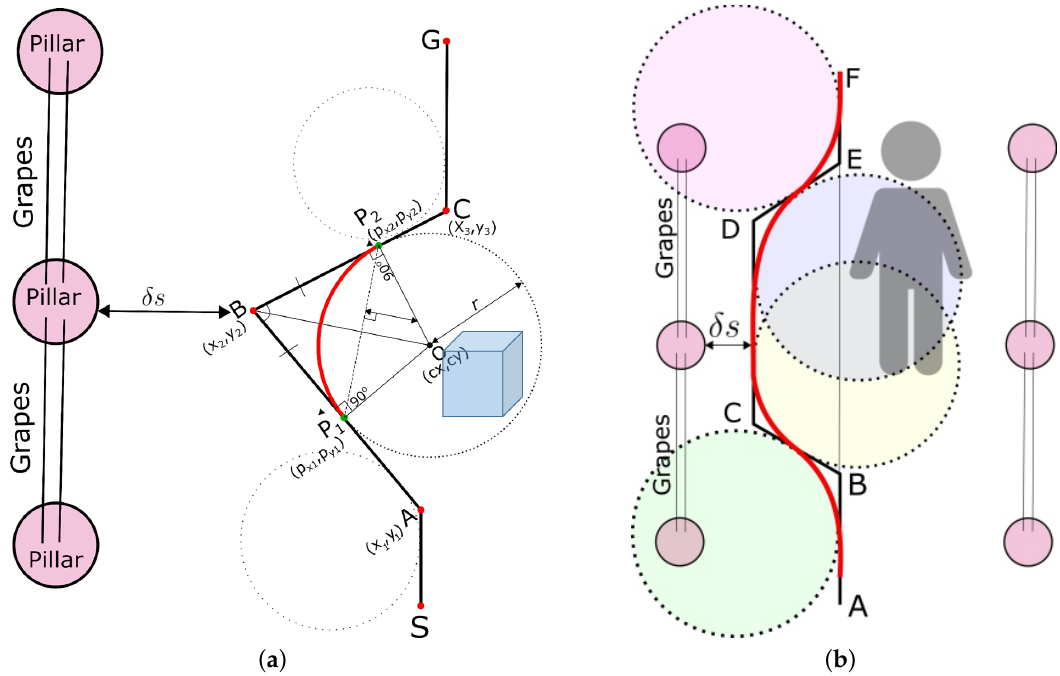
Figure 6. Smooth obstacle avoidance. ( a ) Generation of smooth trajectories at turns using segments of circular arcs. ( b ) Obstacle avoidance using smooth trajectories shown in red color keeping a safe distance from the